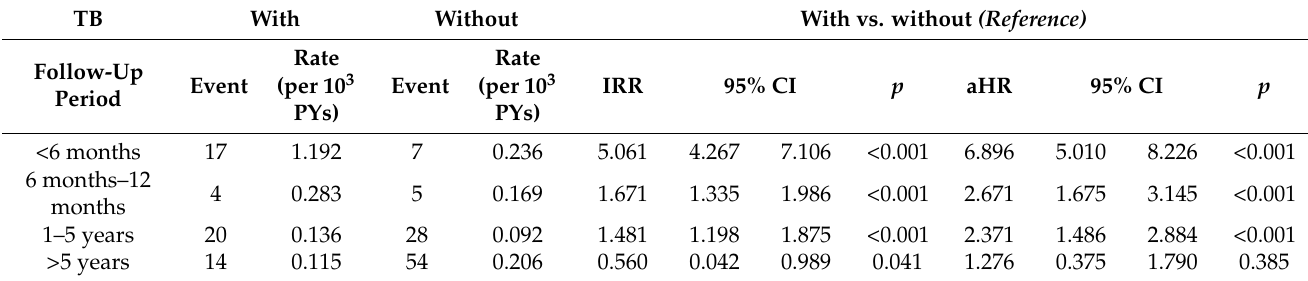
Table 6. Incidence and aHR for aortic aneurysm and aortic dissection stratified by follow-up